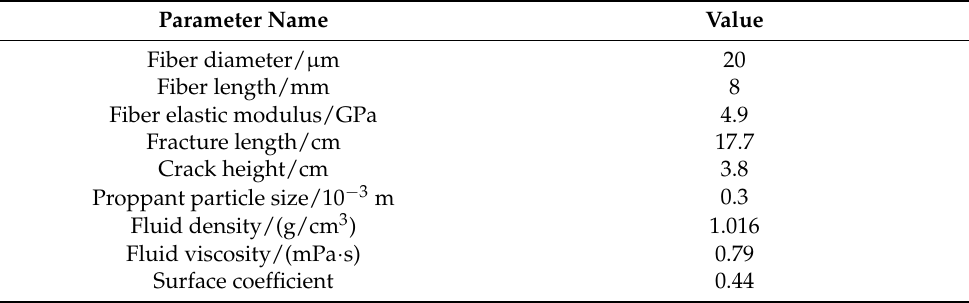
Table 2. Related calculation parameters.